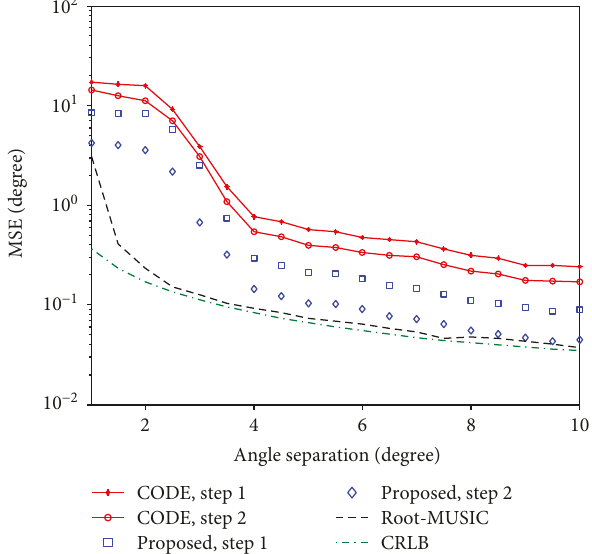
Figure 5: RMSE for θ SNR = 5 dB , 2 sources at θ ULA, N = 8 , γ = 0 5 .